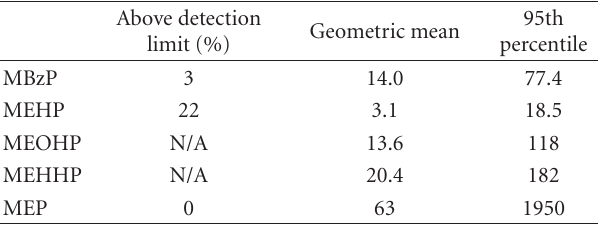
Table 6: Distribution of phthalate metabolite concentrations in serum (SE), sweat (SW), and urine (UR) ( μ g/g). SE-MEP SW-MEP UR-MEP SE-MiBP Mean Median Range